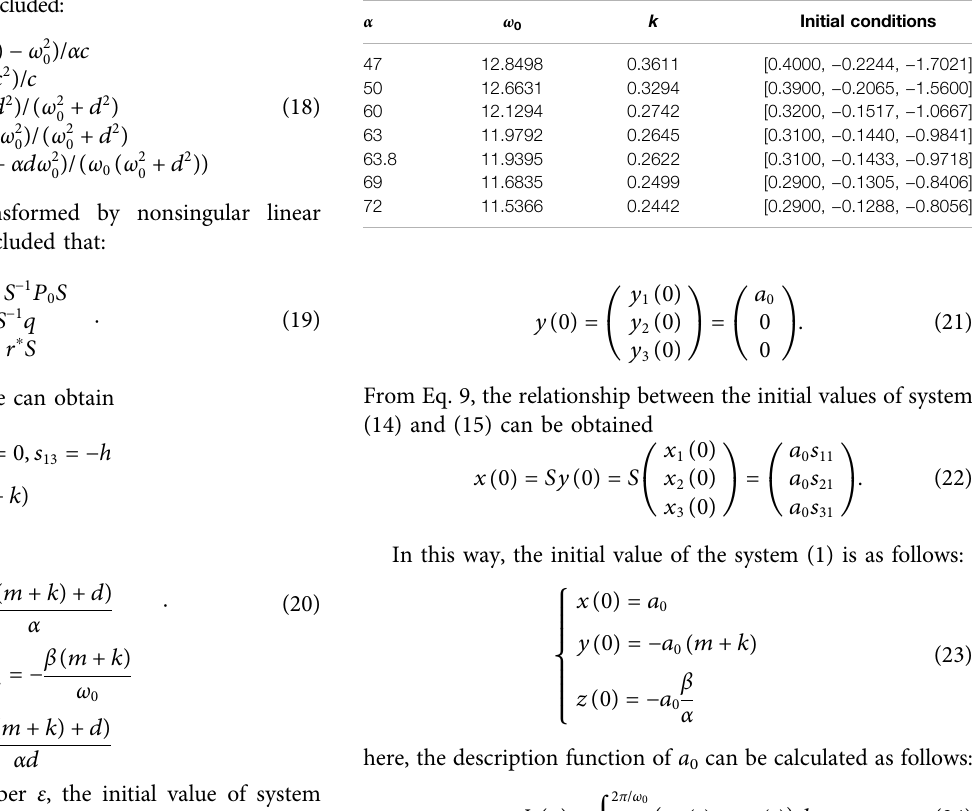
TABLE 1 | Initial conditions of hidden attractors for different α